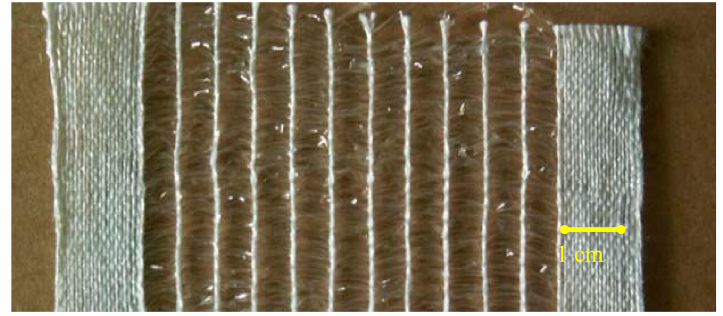
Figure 7. Photograph of dry active textile detail. The active bilayer yarn constitutes the clear strips in the weft (horizontal) of the fabric and the white thread is the polyester yarn of the fabric warp